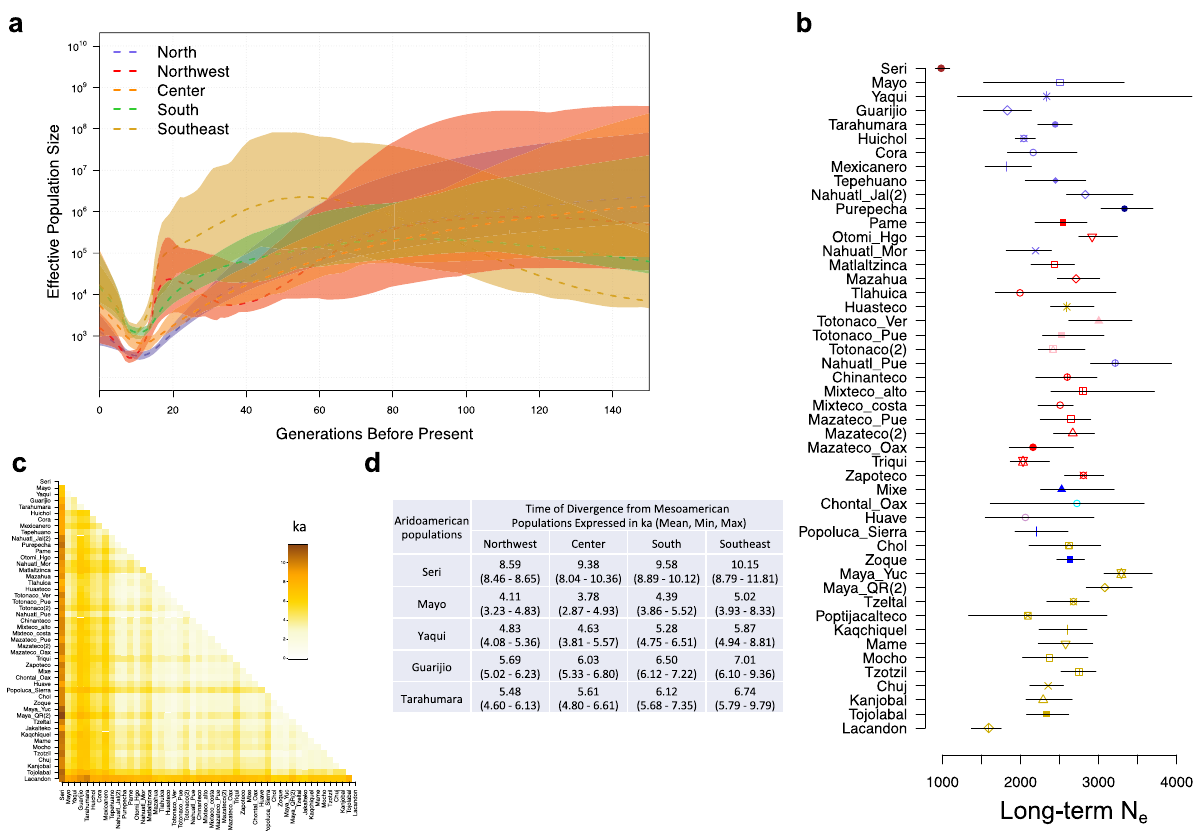
Fig. 3 Effective population size and divergence time estimates. a Demographic measure of effective population size across time showing a decline in population sizes in the fi ve main geographic regions identi fi ed here: North, Northwest, Center, South and Southeast. b Long-term N e of all tested populations, shapes represent the long-term N e and errors bars represent the 95% con fi dence interval. Colors are according to the legends in Fig. 1. Numbers between brackets are the corresponding references. c Divergence time between pairs of populations. d Mean of the observed T between Aridoamerican and Mesoamerican populations expressed in